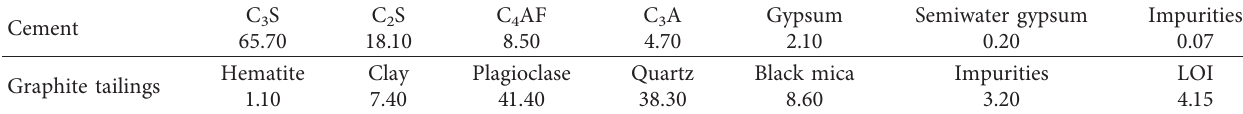
Table 3: Mineral content of cement and graphite tailings (%).